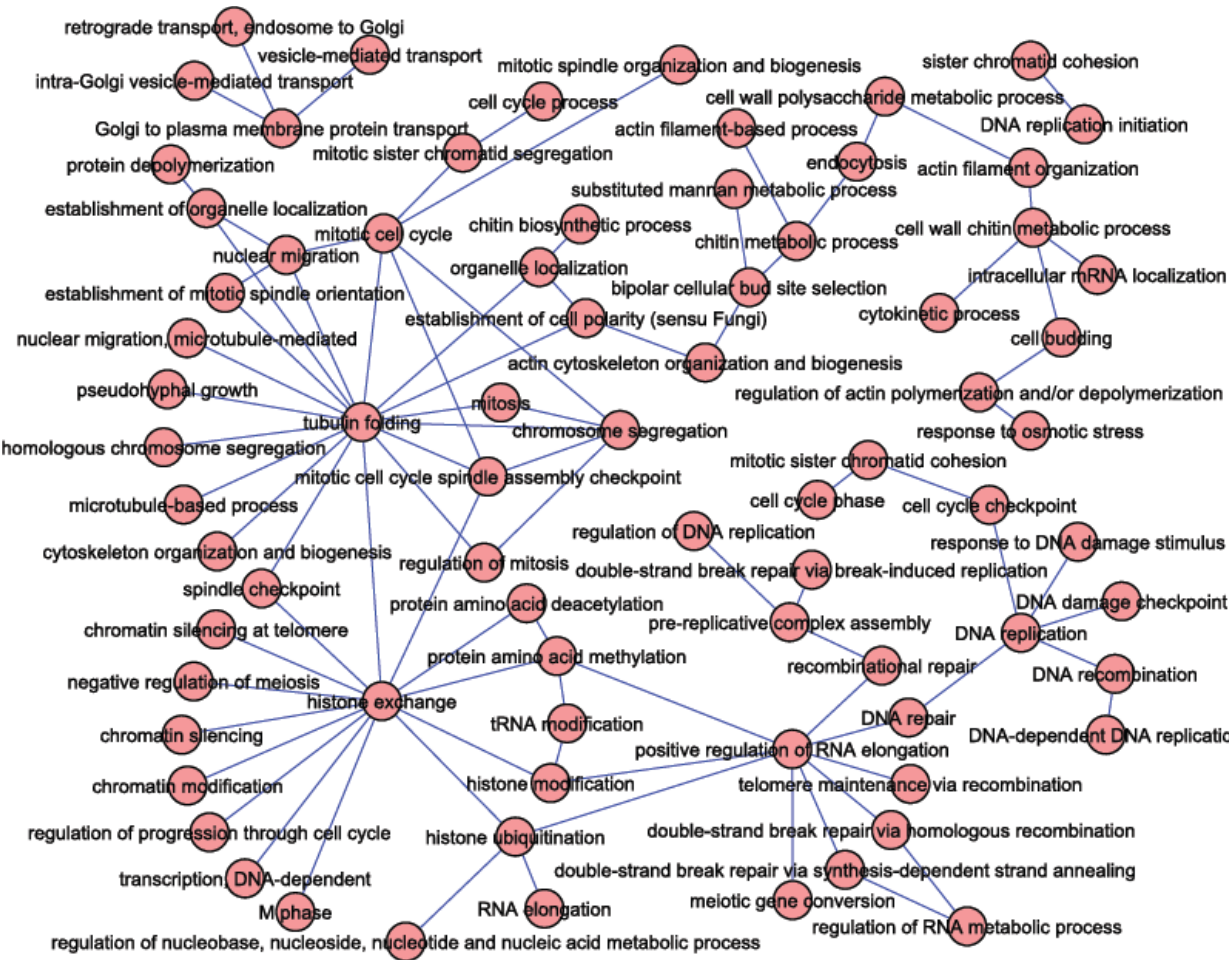
Figure 6. Network of compensatory biological functions revealed by synthetic lethal interaction data. Each node represents a Gene Ontology concept. Each edge represents the existence of extensive synthetic lethal interactions between gene-pairs from the two connected Gene Ontology concept pairs.